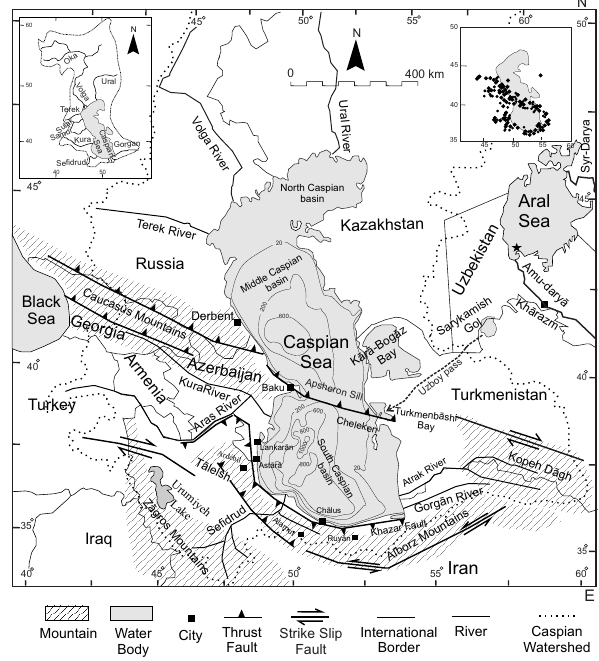
Fig. 1. Modern map of the Caspian Sea and its seaboard countries. The positions of the Aral Sea, the main rivers as well as the re- gion’s main faults are highlighted. The inset on the top left shows the whole watershed area of the Caspian Sea. The inset on the top right shows the recent earthquake epicentres of the region based on Jackson et al.